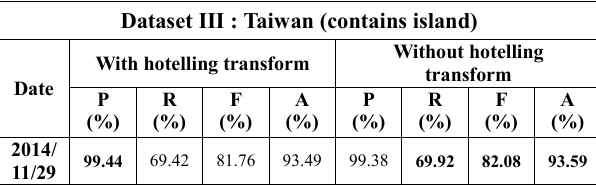
Table 4. Comparison of texture features in dataset III.